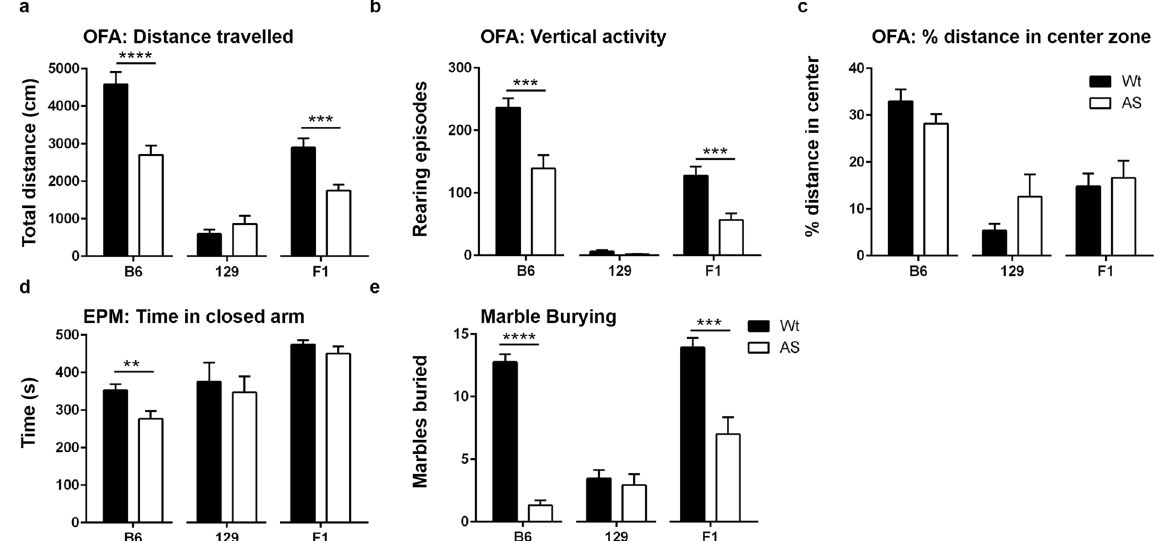
Figure 2. Strain dependent changes in activity, anxiety, and marble burying found in AS mice. Open field assessment (OFA), elevated plus maze (EPM), and marble burying tests highlighted differences between Wt and AS mice, as well as differences in activity levels between background strains. ( a,b ) Both B6 and F1 hybrid AS mice showed significant hypoactivity in the open field through distance travelled and number of rearing episodes (vertical activity). ( c ) No differences were found between Wt and AS mice in the OFA measure of anxiety, % distance travelled in center zone. ( d ) B6 AS mice spent significantly less time in the closed arms of the EPM. ( e ) B6 and F1 hybrid AS mice buried significantly less marbles than Wt mice. The 129 mice showed low amounts of locomotor activity and marble burying compared to the B6 and F1 hybrid mice. For each strain, AS and Wt mice were compared with a Student’s t-test and data are shown as the mean ± SEM, * p < 0.05,